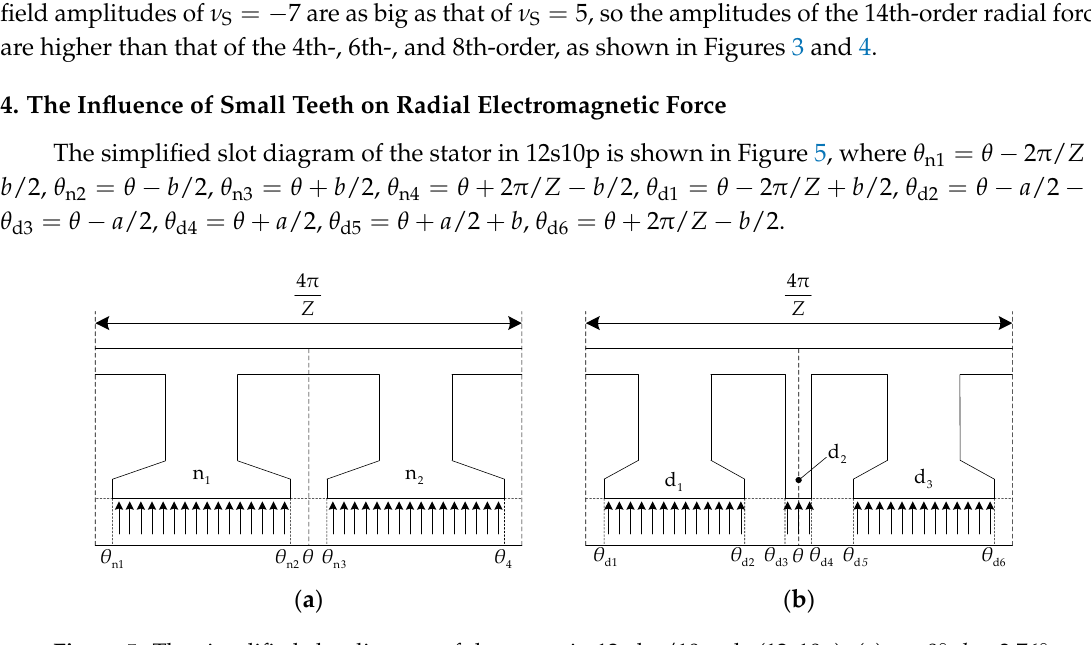
Figure 5. The simplified slot diagram of the stator in 12-slot/10-pole (12s10p): ( a ) a = 0°, b = 3.76°; ( b ) a = 2°, 3.76°, 5.63°, b = 3.76°.